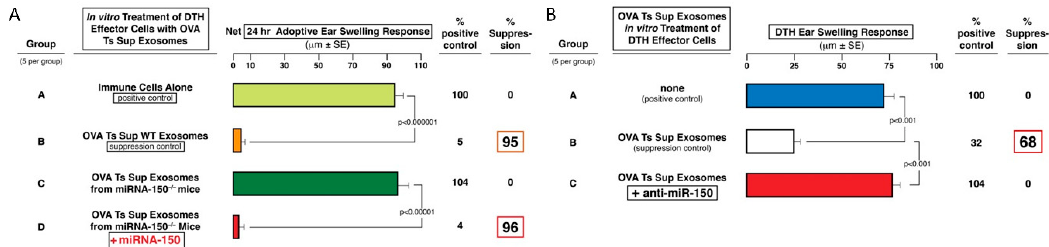
Figure 4. DTH suppression by exosomes from OVA Ag-tolerized mice depends on miRNA-150.